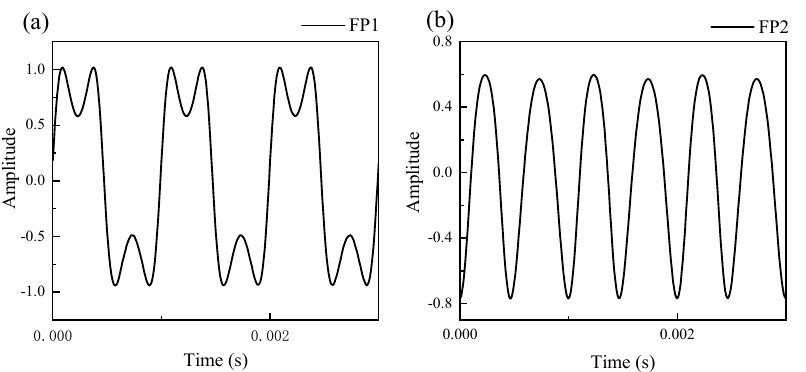
Figure 11. Determination of Q–FFPM–DCM quadrature state dual F–P cavity reference output. The output signal of FP1 ( a ) and FP2 ( b ) cavity in quadrature state.